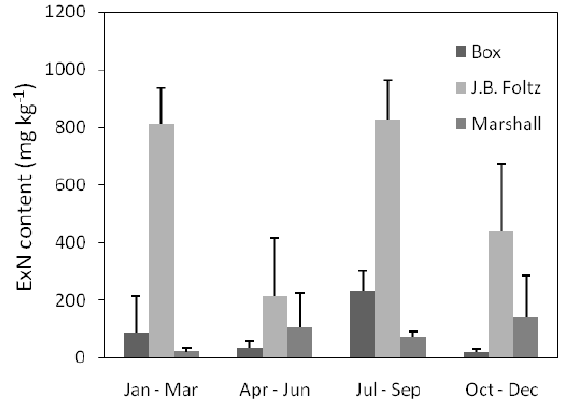
Figure 5. Average exchangeable N content in sediments in the three